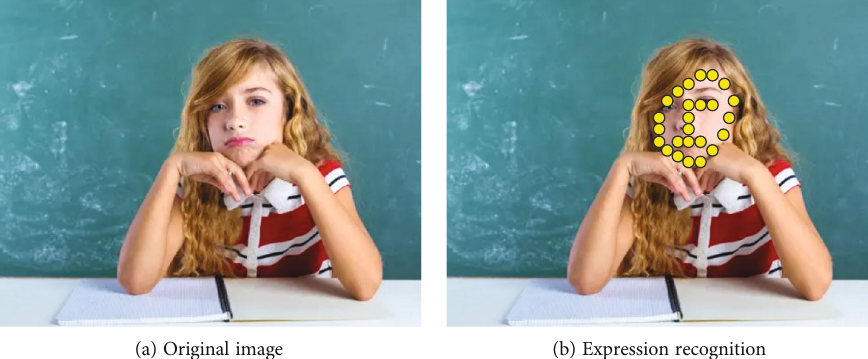
Figure 9: Example image of facial expression recognition of students in English class. Table 1: The recognition e ff ect of the system proposed in this paper for weariness